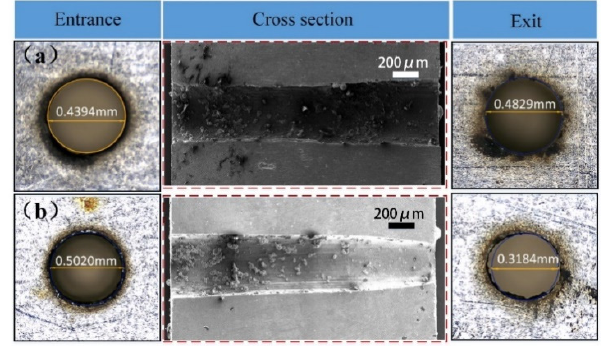
Figure 10. E ff ect of defocusing on the microhole taper: ( a ) − 1.24 ◦ taper; ( b ) 5.24 ◦ Figure 10. Effect of defocusing on the microhole taper: ( a ) − 1.24° taper; ( b ) 5.24° taper.